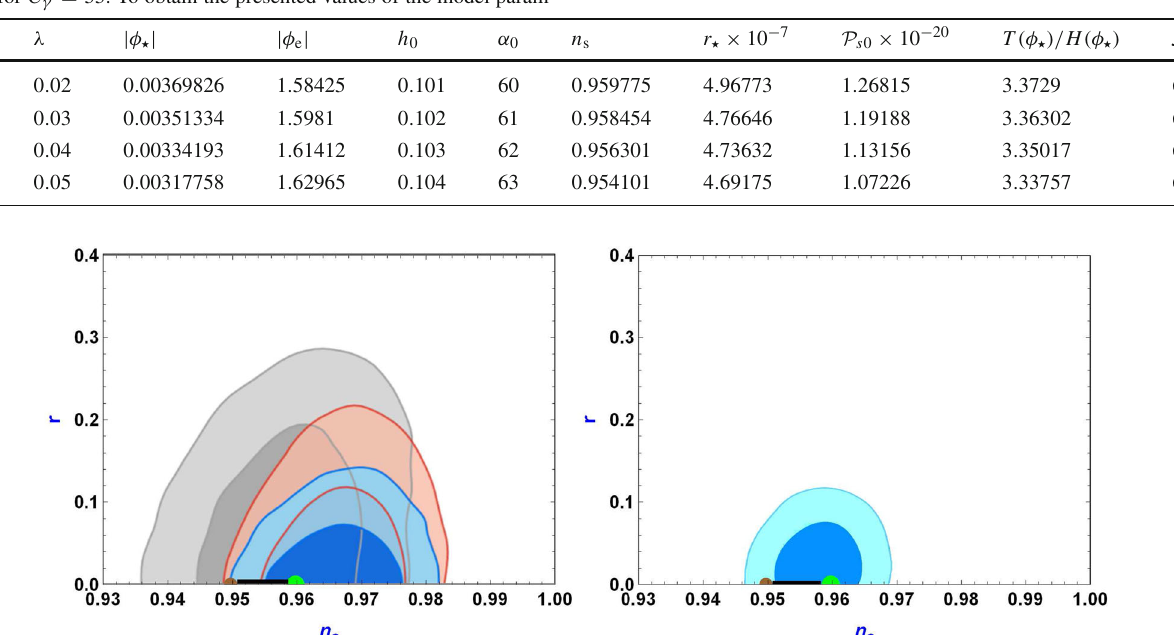
(2015) with blue contours. In the right panel, the results of Planck 2018 are indicated by dark and light blue colors, referring to 68% and 95% confidence levels, respectively. In both figures the thick black lines give the predictions of the non-comoving warm inflation model, while the small, brown, and large, green, circles are the values of n s at the number of e-folds N = 58 and N = 62, respectively